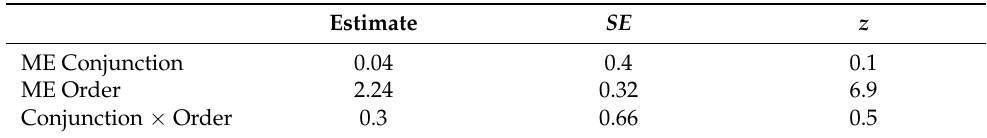
Table 6. Summary of the statistical analyses of participants’ verb choices in the number conflict conditions, Experiment 2.